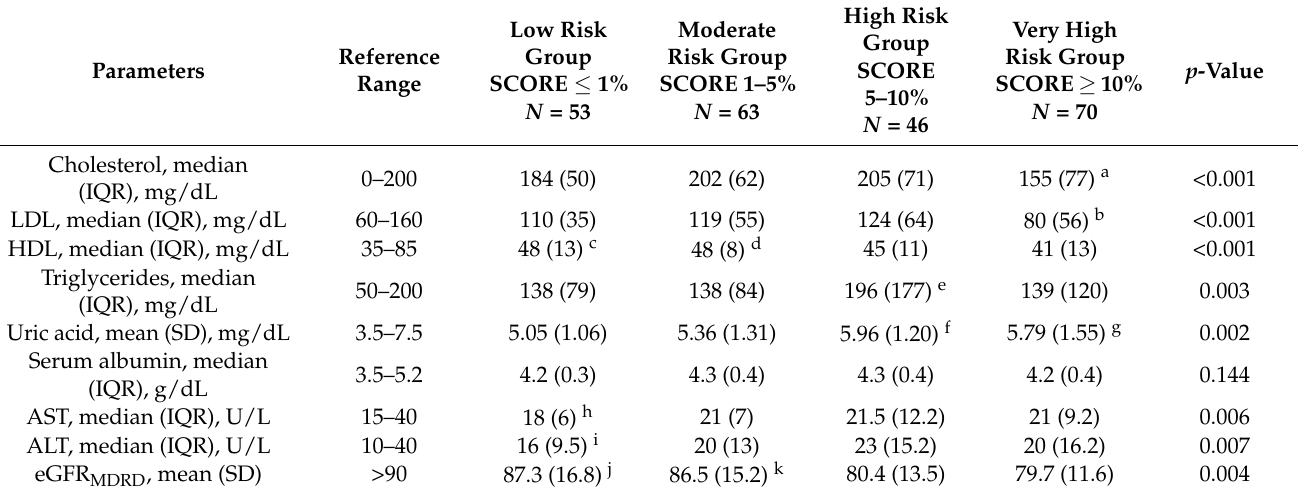
Table 2. Comparisons of Biochemical Parameters Between SCORE Risk